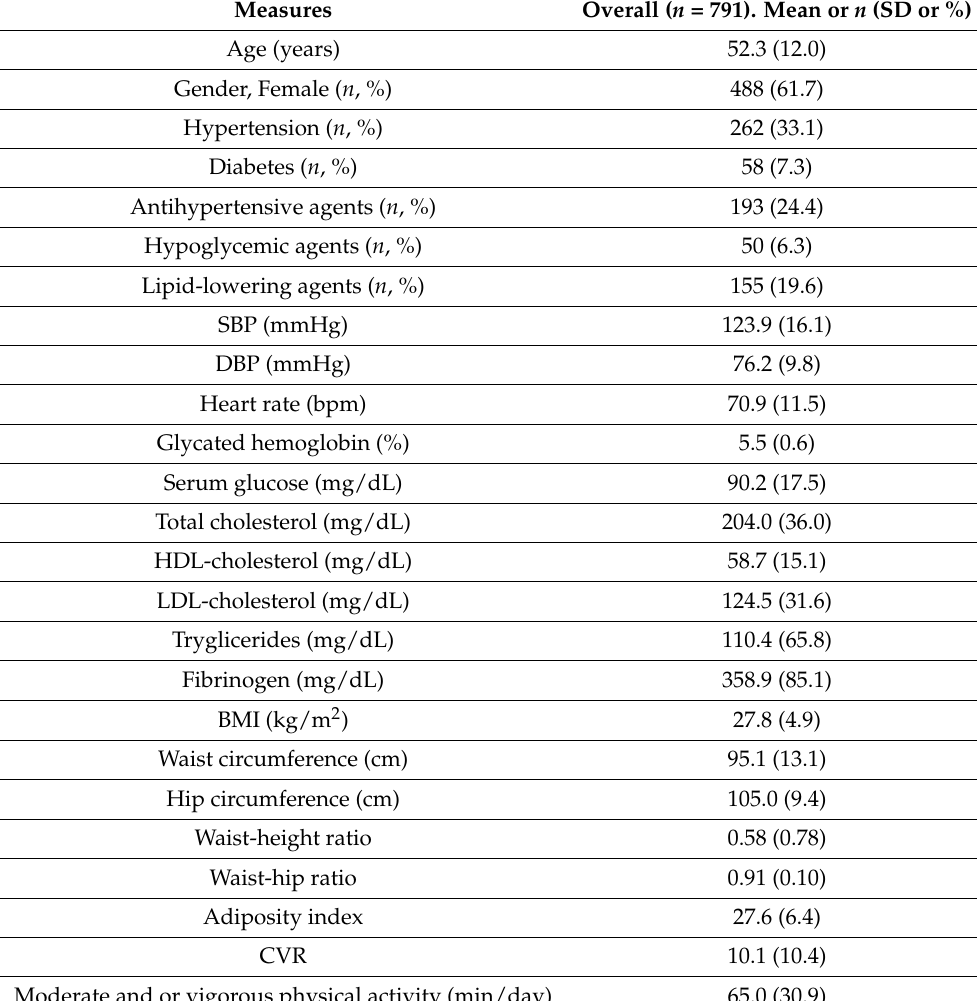
Table 2. Baseline characteristics and clinical characteristics of the study